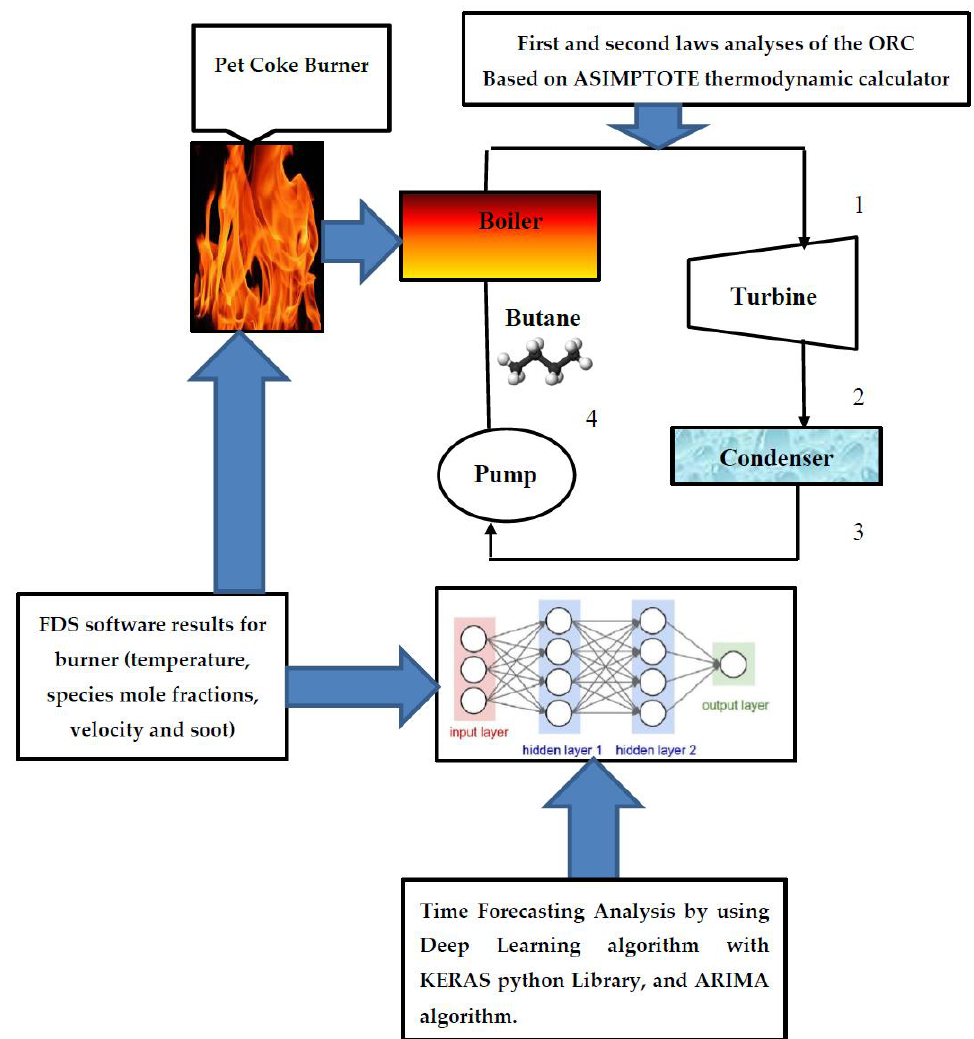
Figure 1. Schematics of an organic rankine cycle system based on pet coke burner. The simulation pet-coke burner is described at the bottom of Figure 1. An Artificial